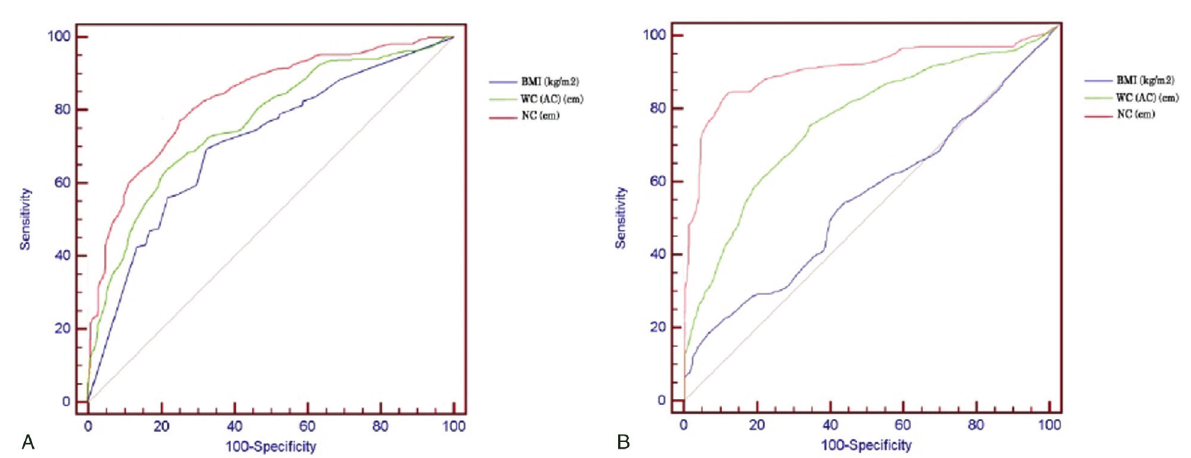
Table 10 Multivariate analyses probability for diagnosing and screening for obstructive sleep apnea and severity P value Variables Presence of OSA (univariate analysis)